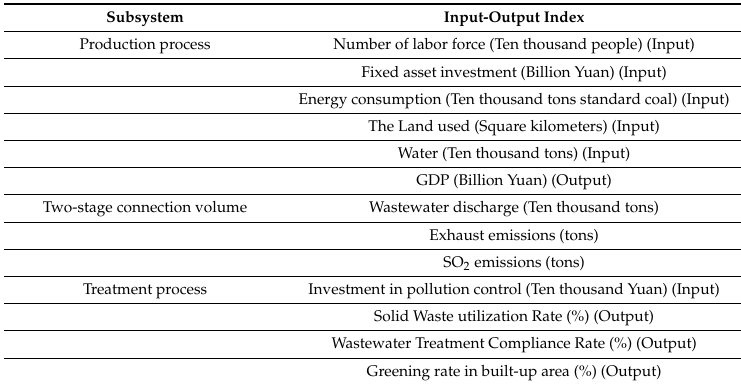
Table 1. Input-output index in di ff erent